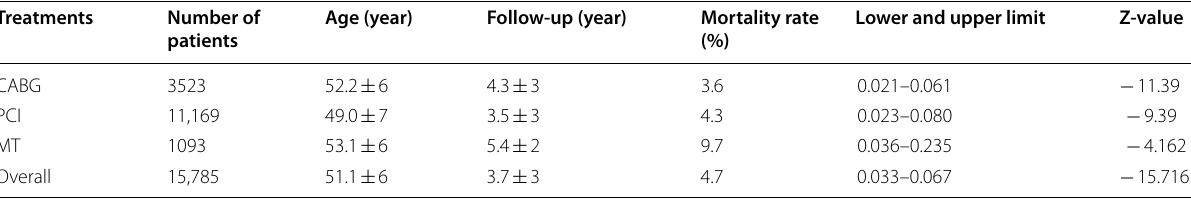
Table 2 Death probabilities following CABG, PCI and MT in CAD patients under 60 years old Treatments